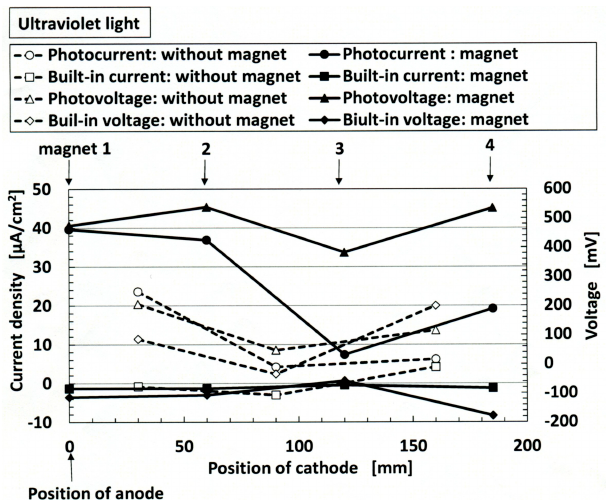
comparison to photoelectricity.